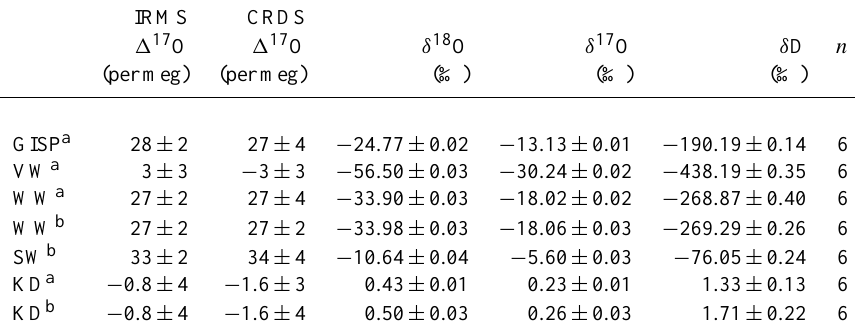
√ n) . n is the sample size.